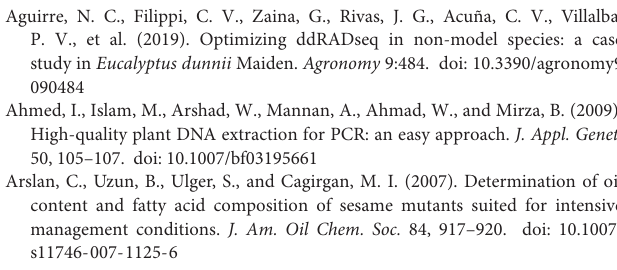
Supplementary Figure 3 | IGB shows the (a) single-nucleotide polymorphism (SNP) changes in the position of 4476867 on LG8. (b) Enzyme digestion with Taq I for this SNP. NP, shattered capsule parent; KP, non-shattered capsule parent. Supplementary Figure 4 | (a,b) Validation of the developed markers: (a) for CAPS marker and (b) for InDel marker. NP, shattered capsule parent;